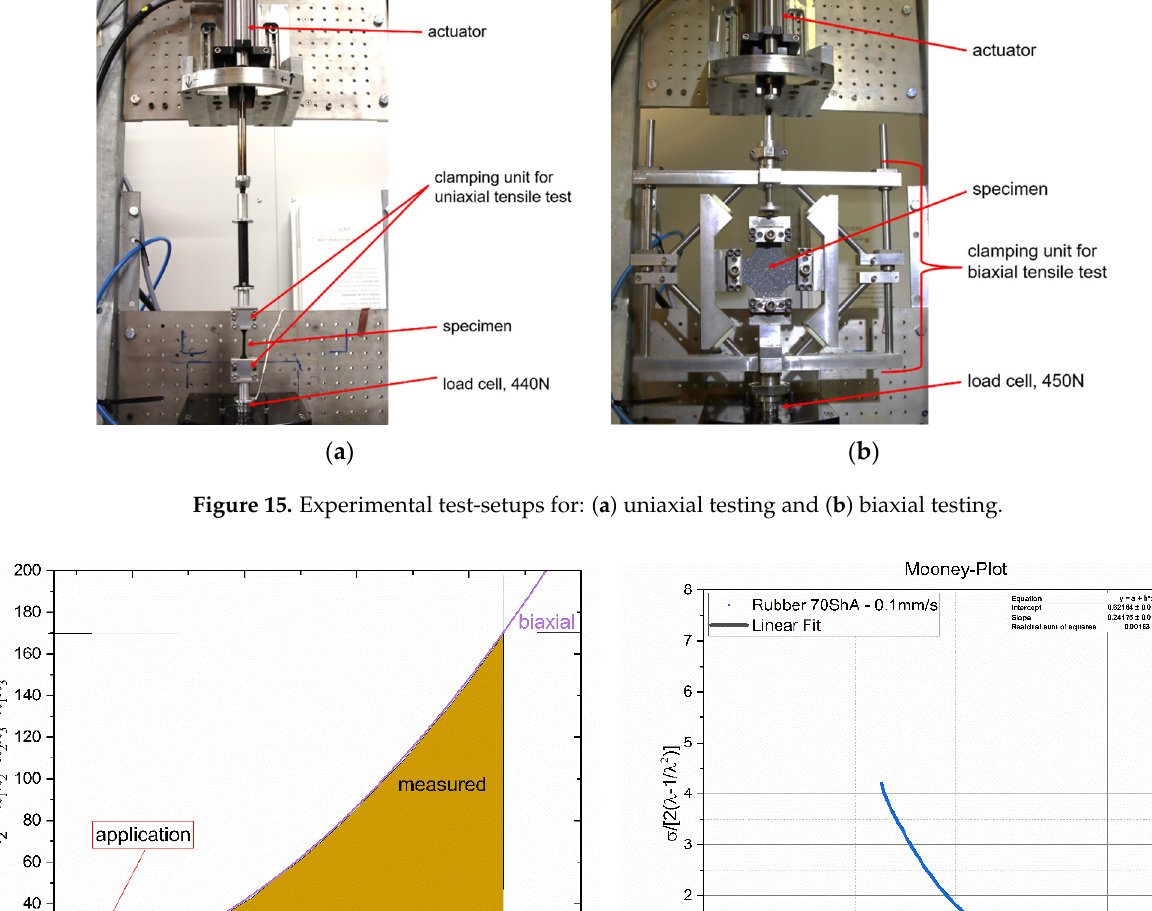
Figure 15. Experimental test-setups for: ( a ) uniaxial testing and ( b ) biaxial testing.